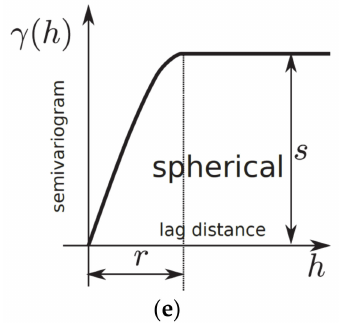
Figure 8. Theoretical semivariogram models (graphs): ( a ) nugget; ( b ) expotential; ( c ) linear; ( d ) logarithmic; ( e ) spherical.